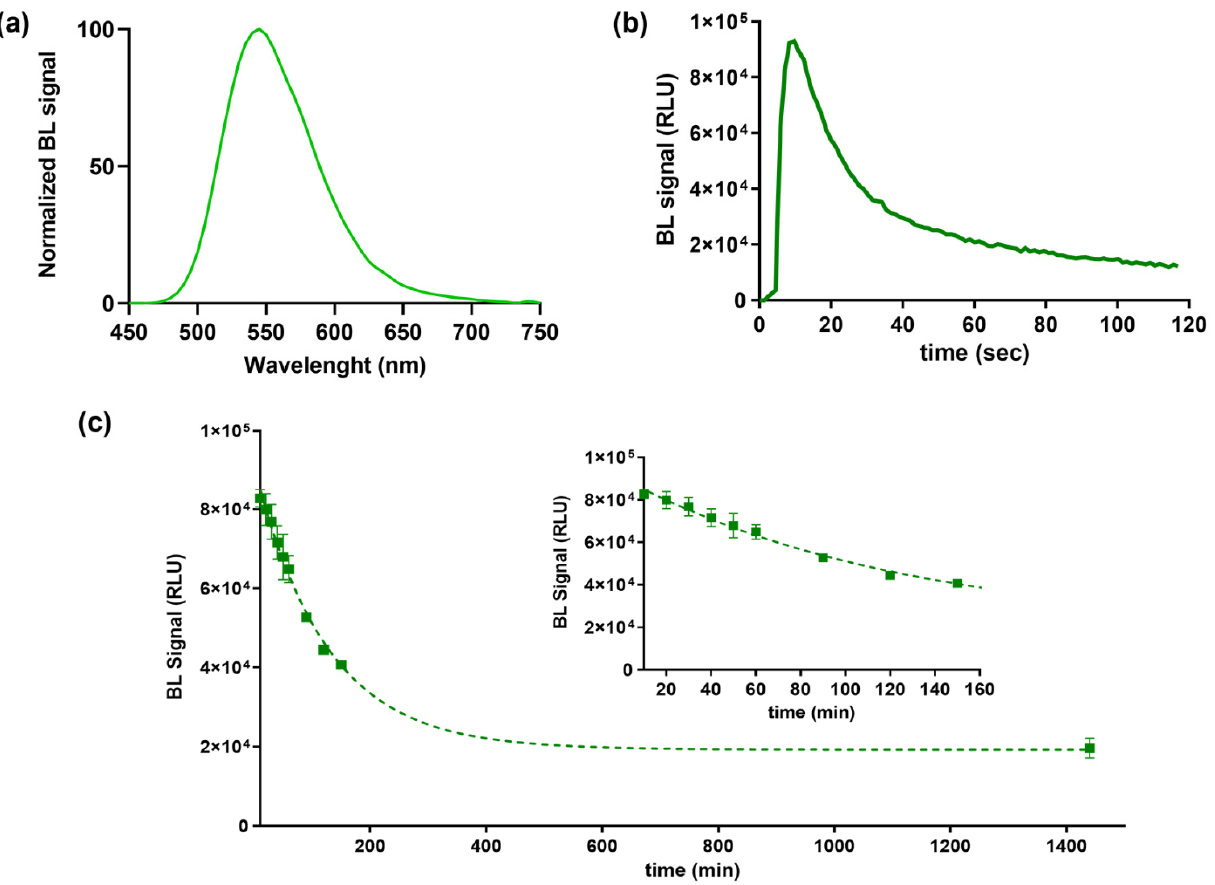
Figure 2. ( a ) Normalized BL emission spectrum, ( b ) emission kinetic and ( c ) heat inactivation studies of purified BgLuc luciferase mutant incubated at 37 °C obtained with Thermo Scientific Varioskan LUX Multimode Microplate Reader. Inset shows the BgLuc heat inactivation study tested until 50% activity loss.